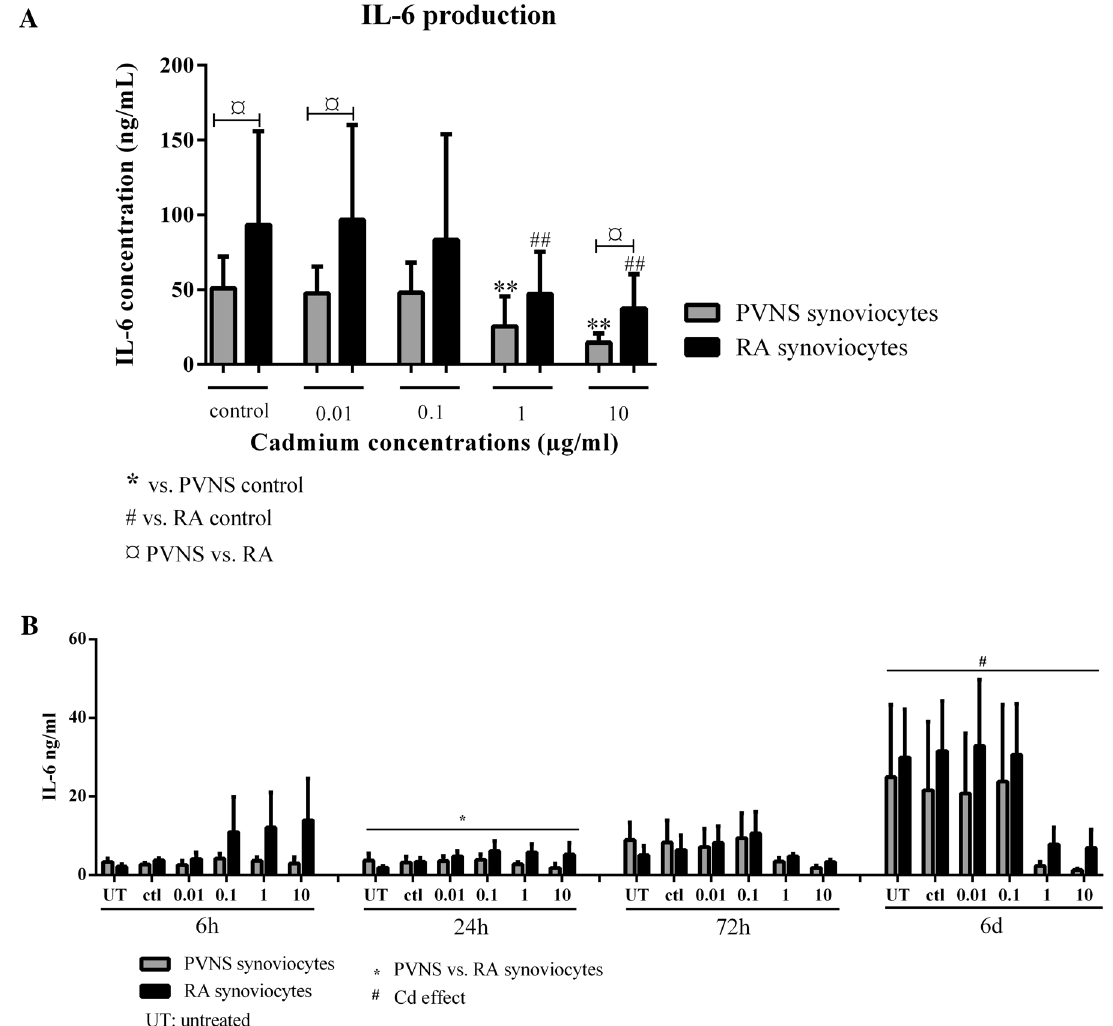
Figure 4. IL-6 production in PVNS and RA synoviocyte supernatants 48 h after Cd exposure. Supernatants from PVNS and RA synoviocytes, used between passages 4 to 9, were collected 48 h after the treatment with increasing concentrations of Cd (0.01 ppm; 0.1 ppm; 1 ppm and 10 ppm; ( A ), n = 10 from 5 PVNS patients and 5 RA patients) or, in independent experiments, following a kinetic study (6 h, 24 h, 72 h and 6 days; ( B ); n = 3 from 3 PVNS patients and 3 RA patients). A quantification of IL-6 production was done by ELISA. Results are presented as mean ± SD, * p <